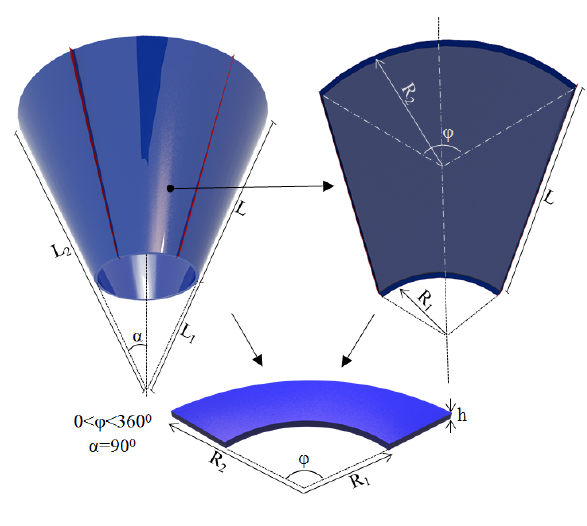
Figure 1: A typical conical shell and annular sector